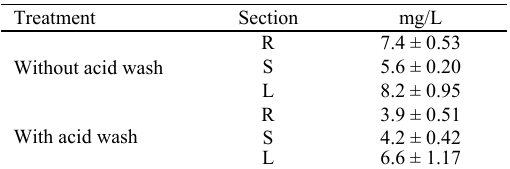
Table 1.Total phenol in mg/L in Eichhornia crassipes section with or without acid wash (R=roots, S=steam, L=leaves)